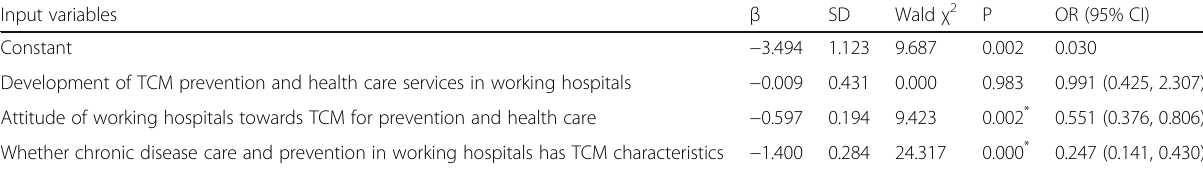
Table 7 Logistic regression analysis of the factors affecting health care professionals ’ overall satisfaction Input variables